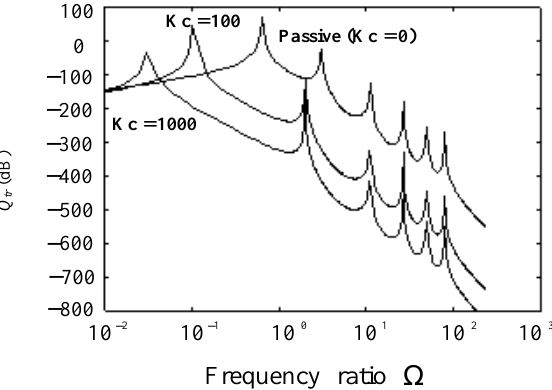
Fig. 4. Comparison of power flow in the passive and hybrid isolation systems ( µ = 0 . 5 ,ω 1 /ω 0 = 2 ,γ = 2 ,δ = 0 . 001 ,ξ = 0 . 01 ).